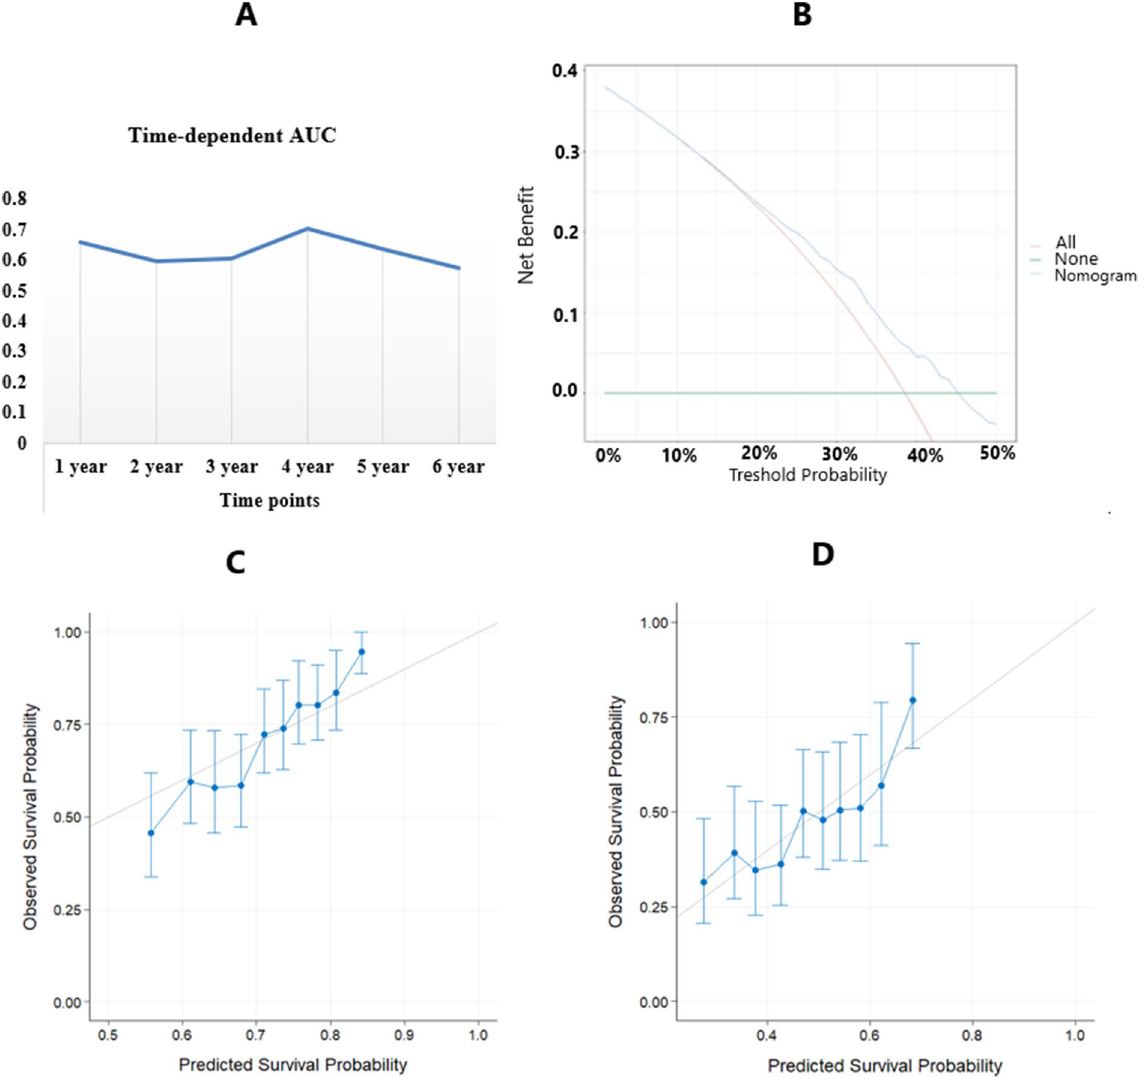
Figure 4. ( A ) Time-dependent AUC summary at evaluation time points. ( B ) Decision curve analysis. ( C ) Internal calibration using bootstrap resampling at 1 year and 2